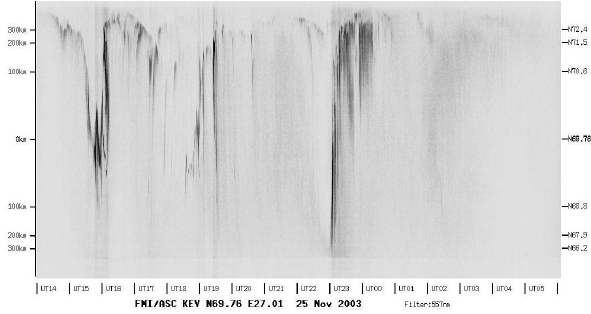
Fig. 5. All Sky Camera Keogram from Kevo for the 25 Novem- ber 2003. The image shows 557.7nm aurora, and has been made negative for clarity.